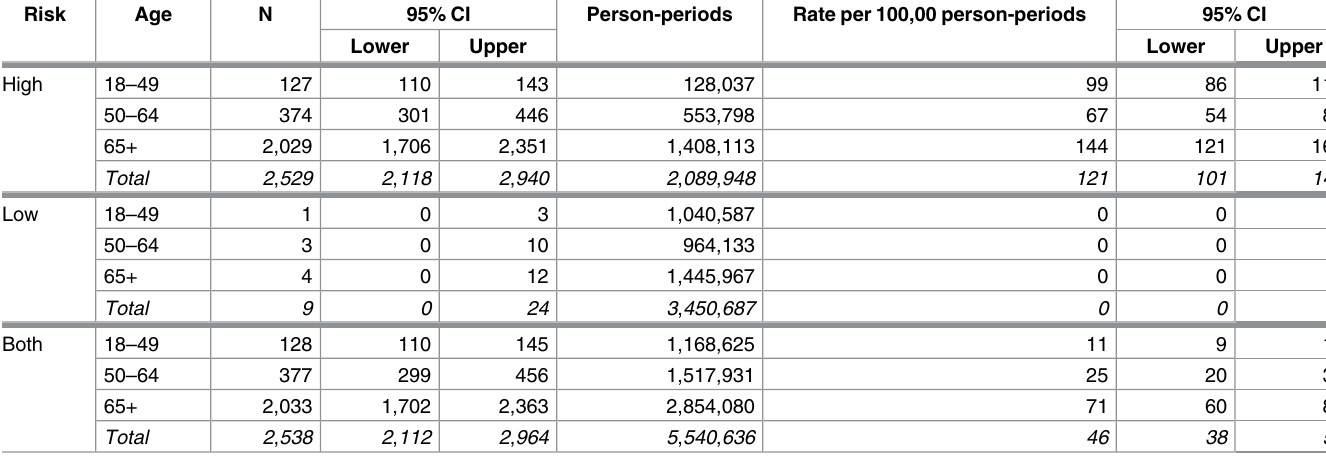
Table 2. Annual estimates of influenza-attributed hospitalizations 1 by risk and age group averagedover five respiratory seasons. Risk